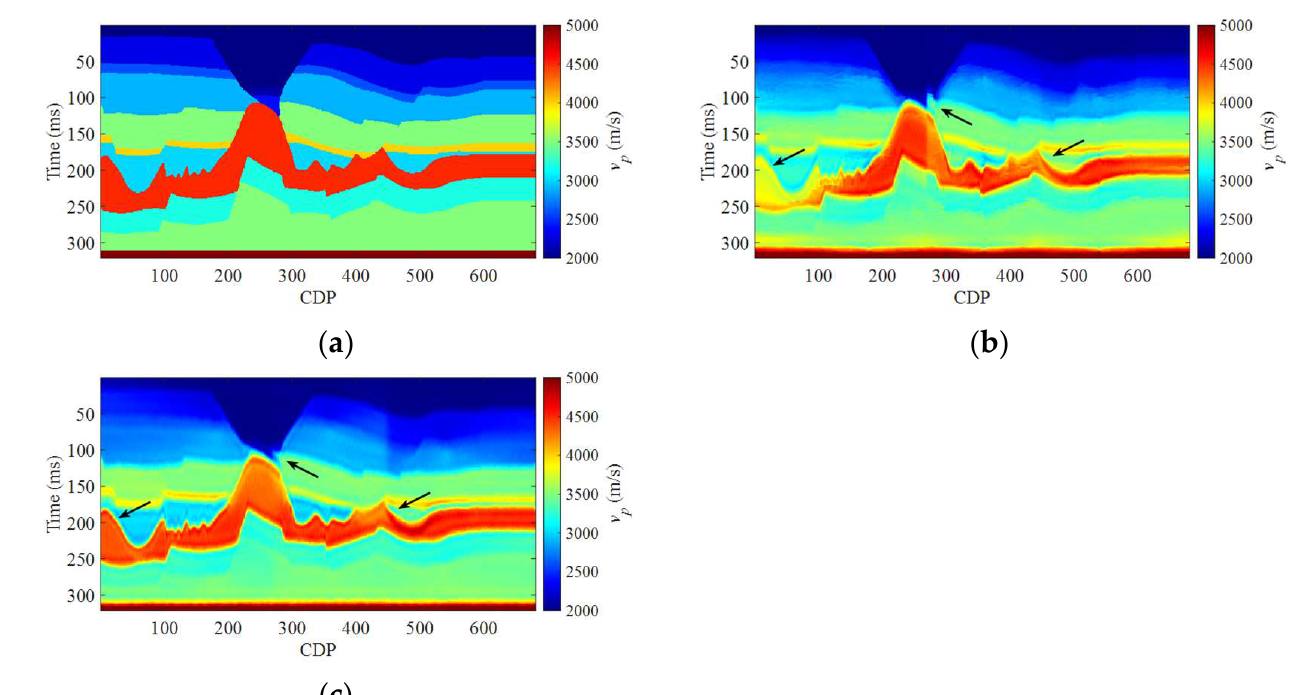
Figure 10. Prestack seismic inversion results of v p , ( a ) reference model, ( b ) inversion result by KI model, ( c ) inversion result by FM-NLM. Table 2. The REs of prestack seismic inversion results.